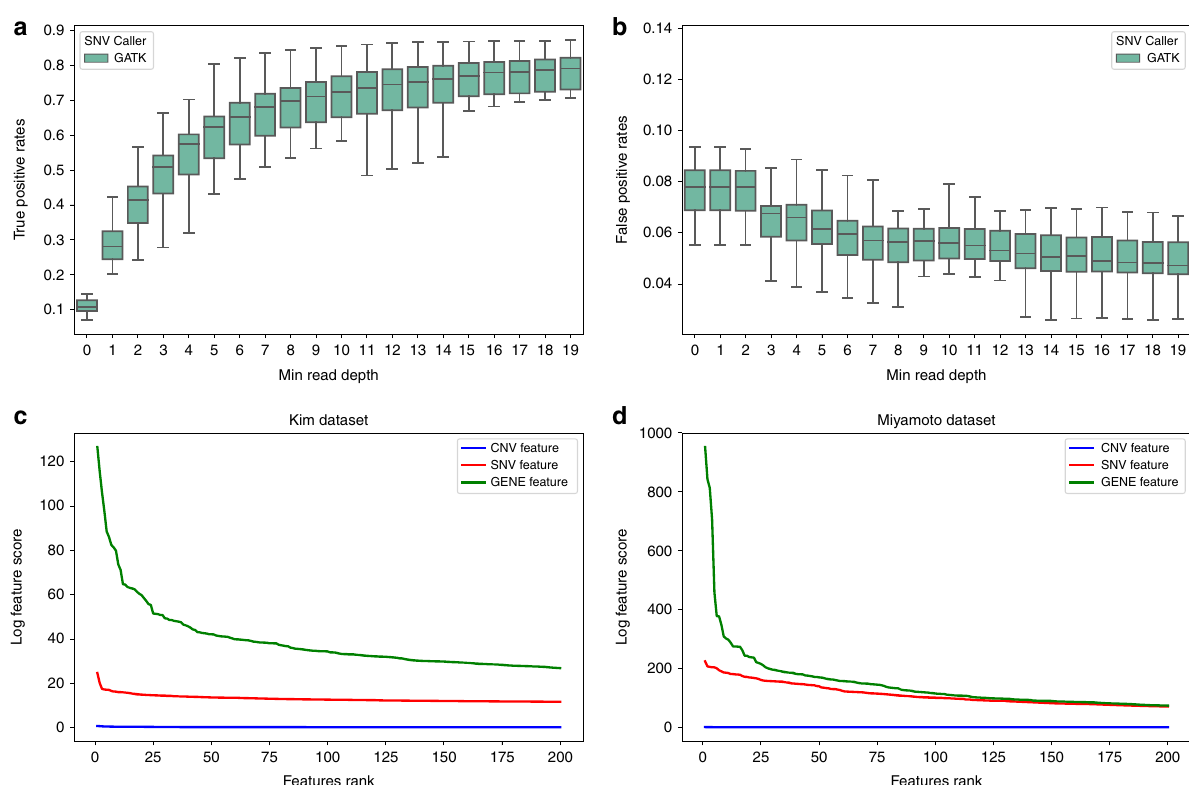
Fig. 1 The performance measurements of GATK SNV calling and SSrGE pipelines. a , b Performance measurement of GATK SNV calling pipeline. Box plots of true positive rate ( a ) and false positive rate ( b ) with respect to the read depth at the called SNV position. The rates are calculated from GATK SNV calling pipeline, using hg19 reference genome to align modi fi ed scRNA-seq reads from a subset of 20 cells from the Kim dataset, which were introduced 50,000 random arti fi cial mutations the exonic region of the reads. Error bars represent standard deviation. c , d Comparisons of importance the different types of features in SSrGE models, with respect to the ranking, in Miyamoto dataset ( c ) and Kim dataset ( d ). The scores of the SNVs and CNVs correspond to the sum of the coef fi cients inferred by the SSrGE models. The gene score is the sum of the SNVs scores for a particular gene. Blue: CNV feature; Red: eeSNV feature; Green: gene